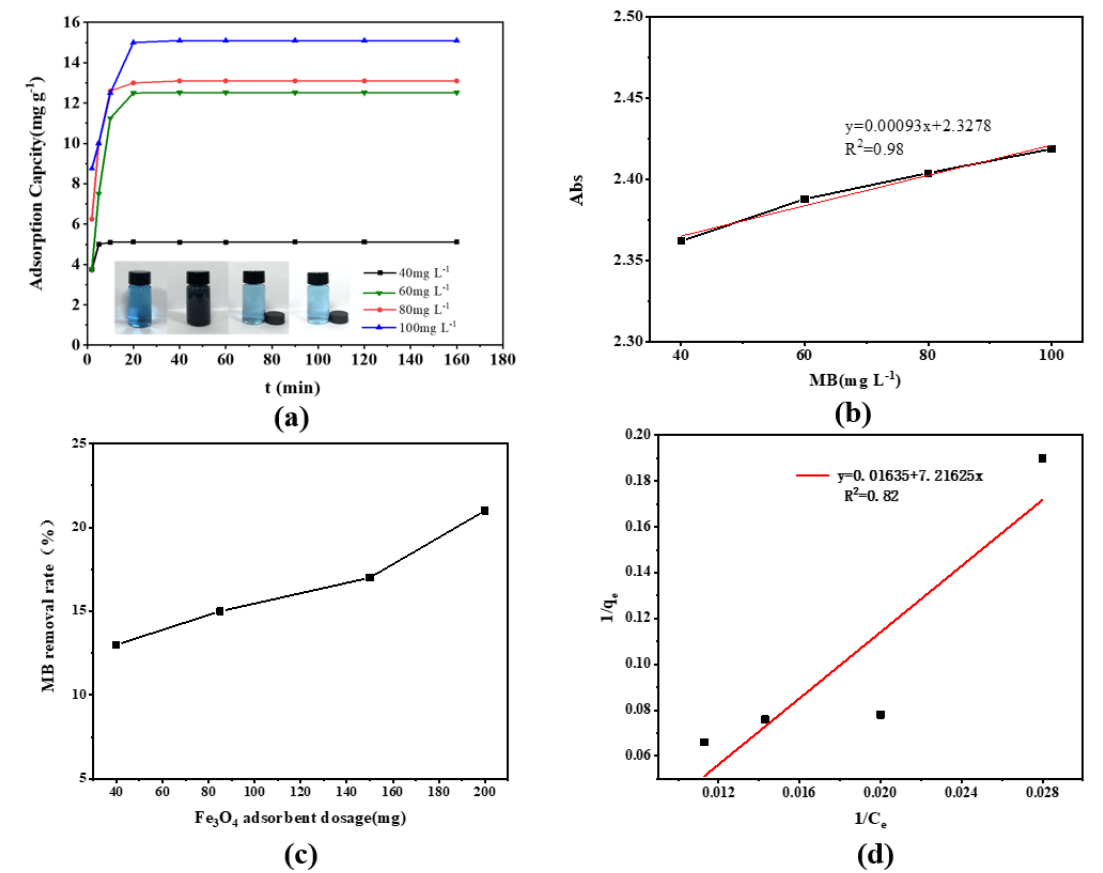
Figure 5. ( a ) Fe 3 O 4 at different initial concentrations of methylene blue adsorption curve (The illustration shows the methylene blue solution, the solution after adding Fe 3 O 4 magnetic adsorbent, the solution after 2 min of adsorption and 160 min after adsorption, from left to right); ( b ) the red line is the standard curve of the relationship between methylene blue concentration and absorbance; ( c ) the influence of the mass of adsorbent on the removal rate of MB; ( d ) the red line represents the Langmuir isotherm of Fe 3 O 4